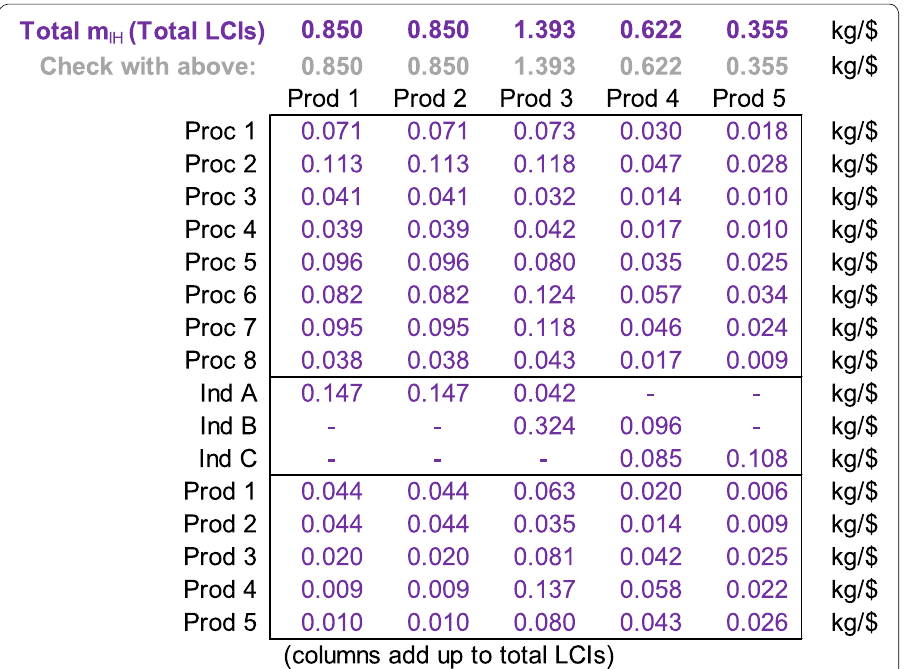
Fig. 7 Final outcome of decomposition of LCIs by final - stage inputs , showing impacts from final-stage processes and products and direct final-stage inputs from industries to produce a